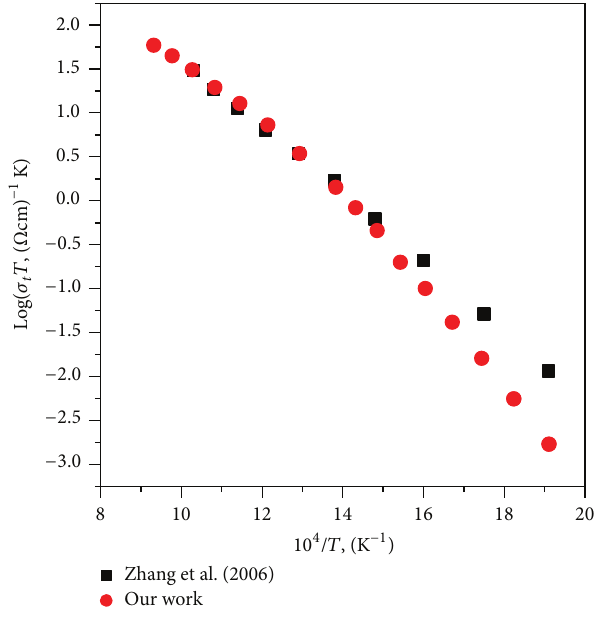
Figure 10: Arrhenius plots of the total conductivity (𝜎 𝑡 ) GDC20 in air of our work ( ◼ ) as compared to that of Zhang et al. (2006) ( e